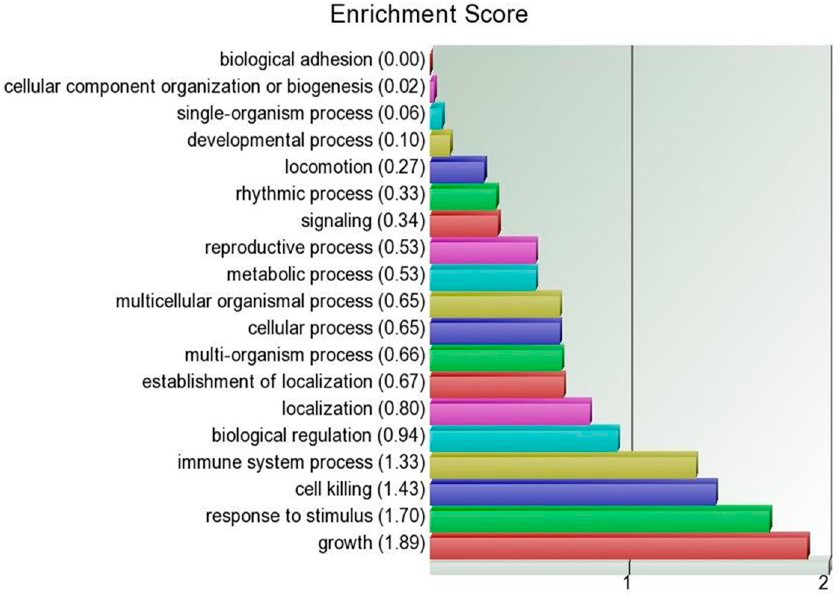
Figure 4. ( A ) Hierarchical clustering concurrent with (B) volcano plot of the genes obtained from the Affymetrix gene chip. Thick vertical lines and horizontal lines in the volcano plot represent the chosen cut off of fold change of 1.5 and p < 0.05.